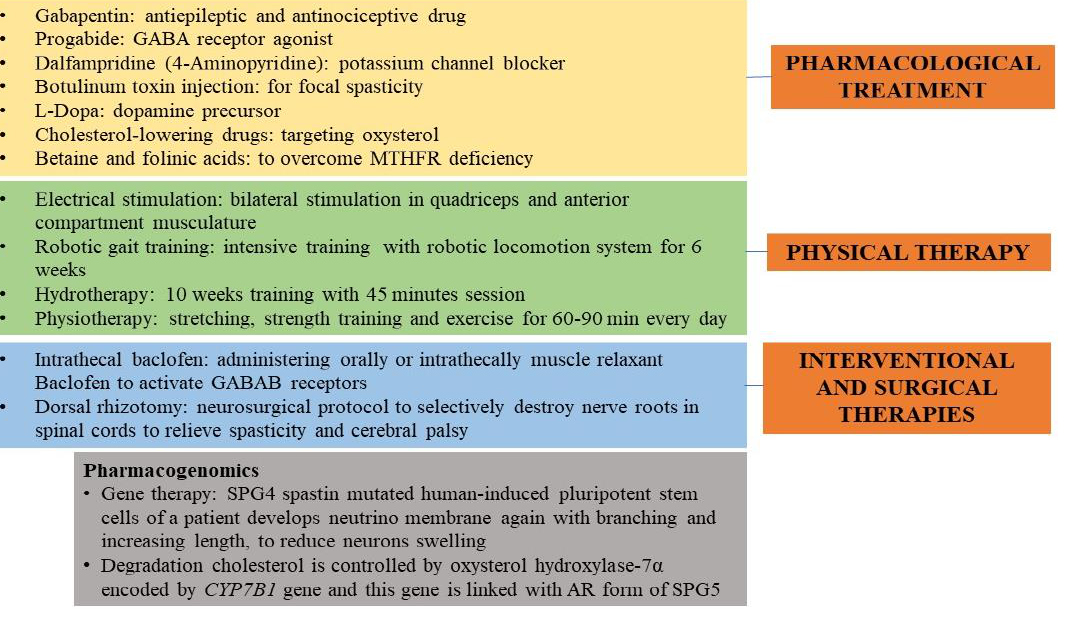
Figure 4. Therapies and treatment are administered to HSP individuals. The picture illustrates the pharmacological, physical, interventional, and surgical treatments given to HSP people to soothe the spasticity and improve their gait. A pharmacogenomics approach is also reported.